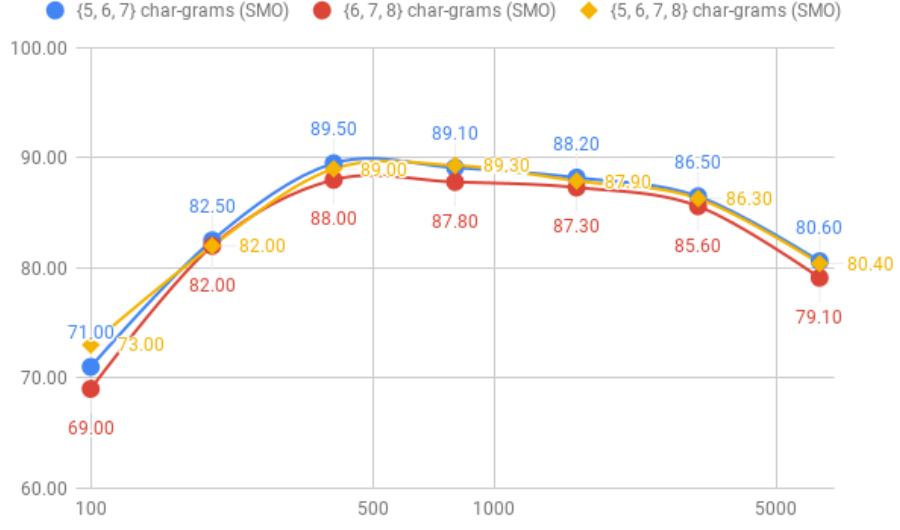
Figure 13. Comparison of the accuracy between {5, 6, 7}, {6, 7, 8} and {5, 6, 7, 8} char-grams for the SMO